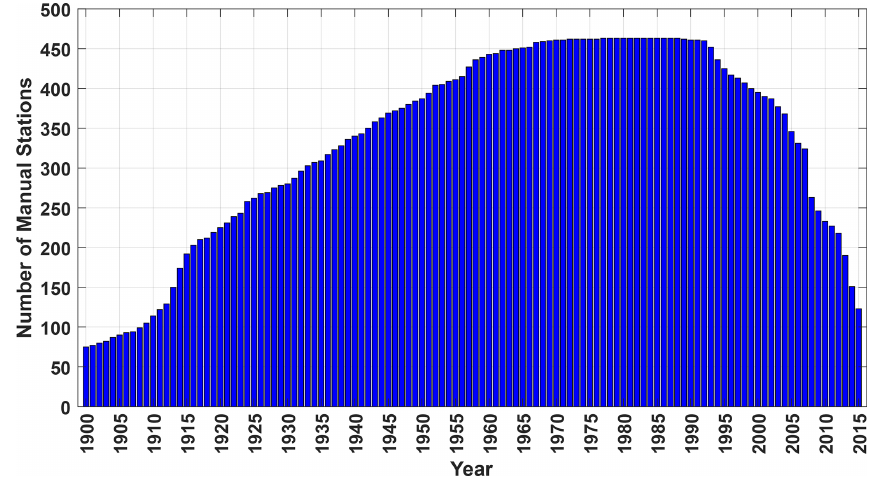
Figure 1. Evolution of the quantity of manual stations in the ECCC operational network from 1900 to 2015 (from Mekis et al., 2018).